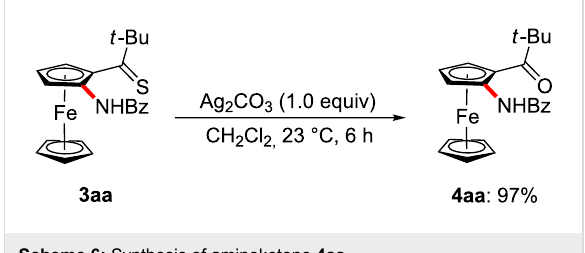
Scheme 6: Synthesis of aminoketone 4aa